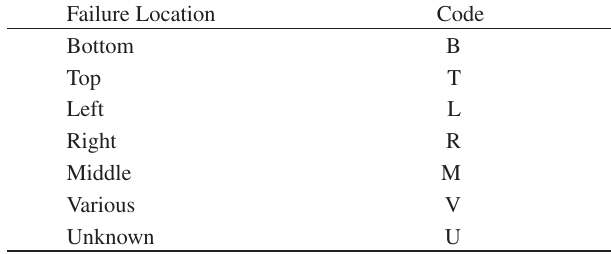
Table 3. Codes related to the third characteristic (“local”) of the failure mode 20 .